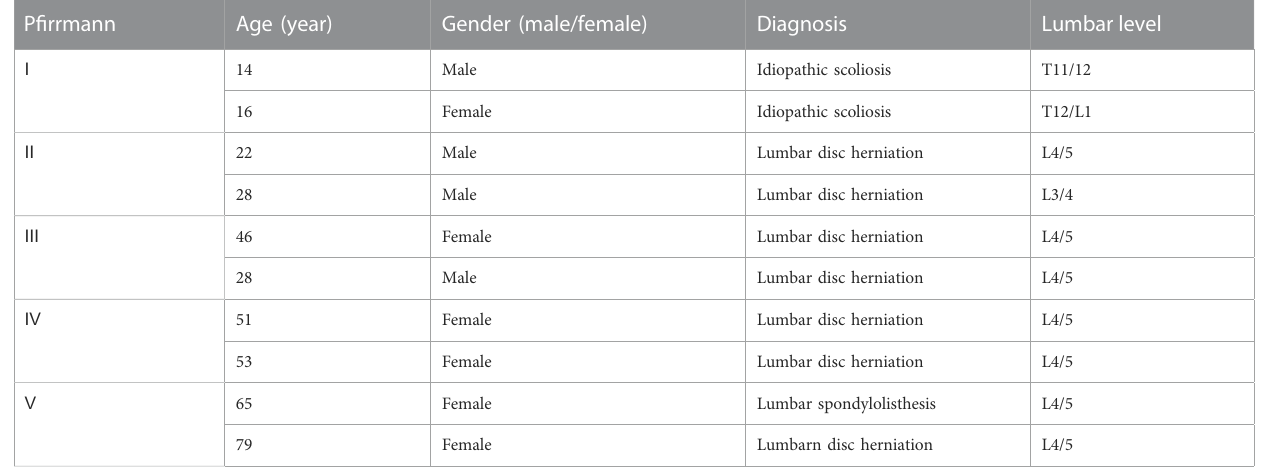
TABLE 1 Clinical data of